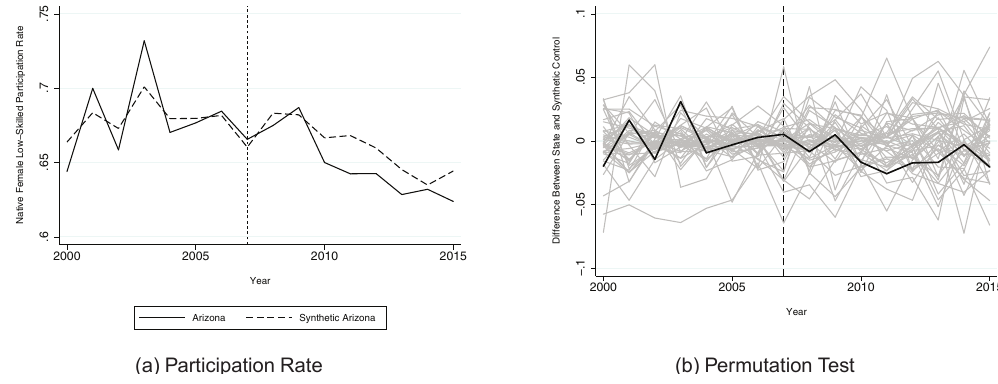
Figure 5 Native low-skilled female participation rate